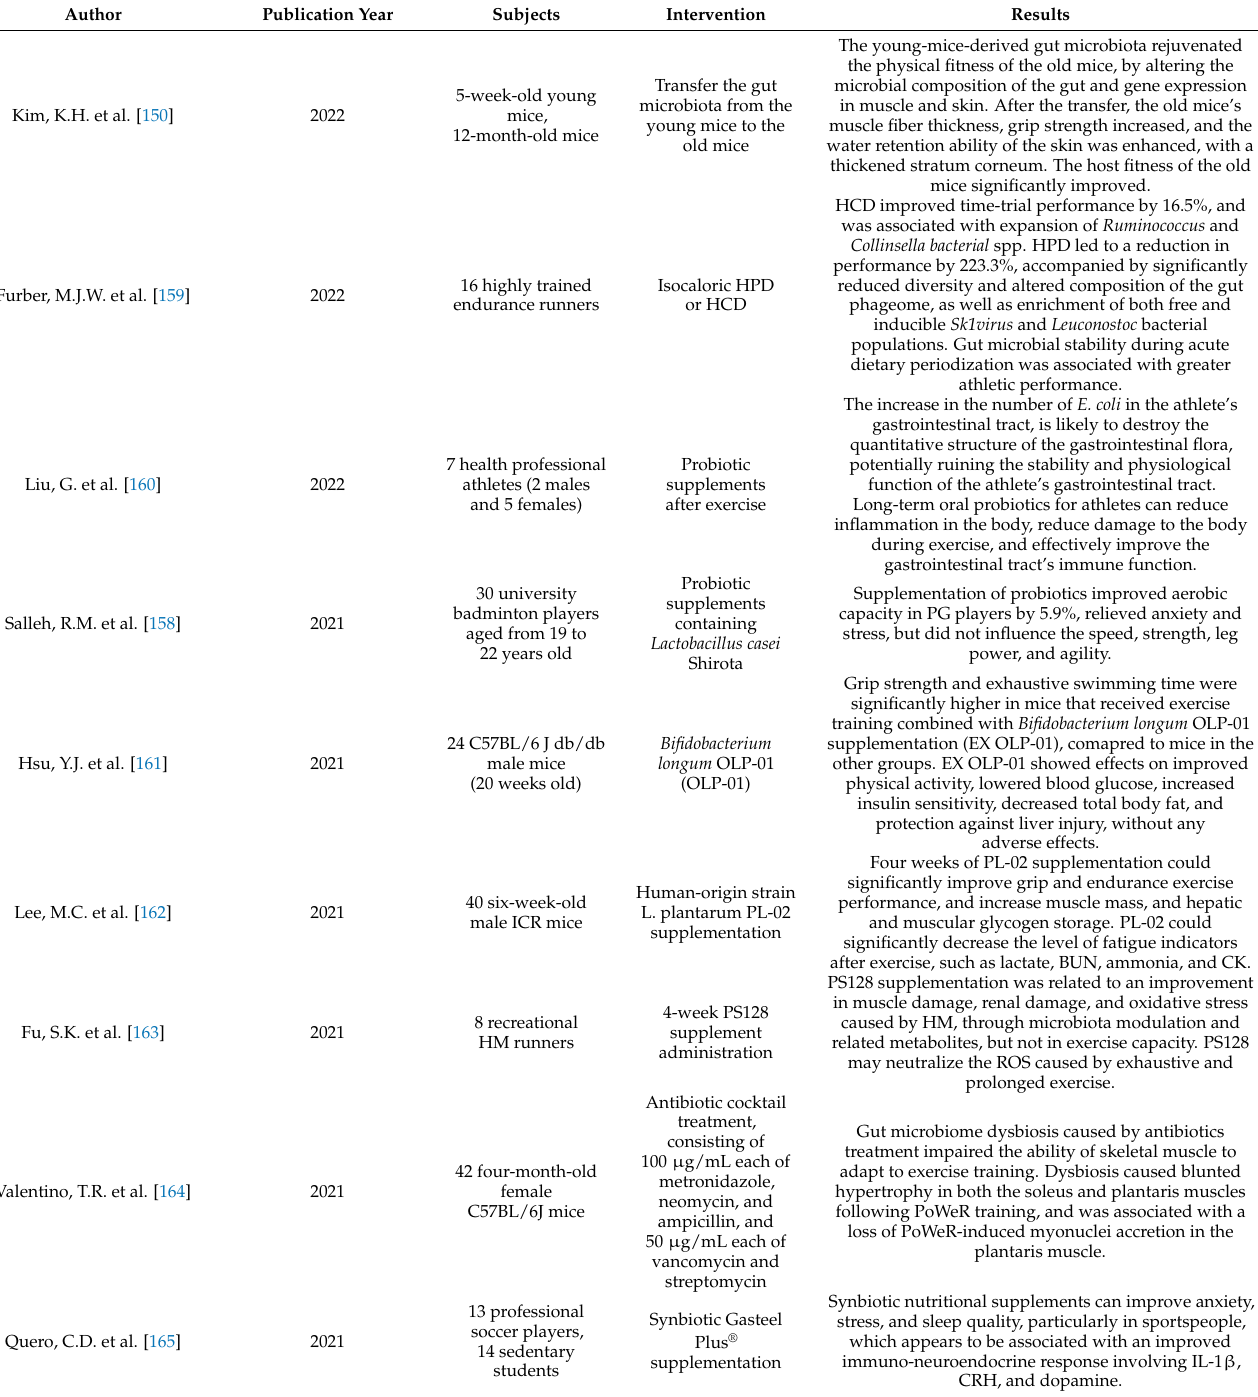
Table 9. Impact of the gut microbiome on